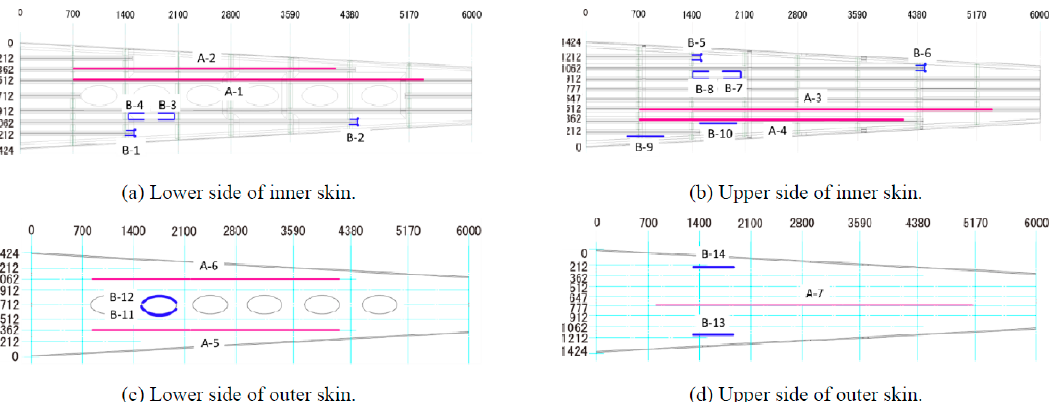
( b ) Figure 20. ( a ) Physical map of composite wing box; ( b ) Internal structure of wing box [86]. As shown in Figure 21, in the layout of FBG arrays, the researchers equipped the wing box with seven FBG arrays (A-1–A-7), eight long-length FBGs with 300 mm gauge length (B-1–B-8), six long-length FBGs with 500 mm gauge length (B-9–B-14). Each array had about 30 or 40 FBGs with 10 mm gauge length and FBGs were arrayed in a 100 mm pitch along the fiber. The stress distribution of tensile strain A-1 is obtained by combining finite element analysis with variable load. As shown in Figure 22, it can be seen that the measured and calculated values have a good match. The experimental results also show the stress distribution of B-1. It can be seen from the diagram that the stiffness of B-1 varies locally on the tip of the truss and the strain varies greatly. The case shows that FBG arrays have good performance in strain and load distribution monitoring of